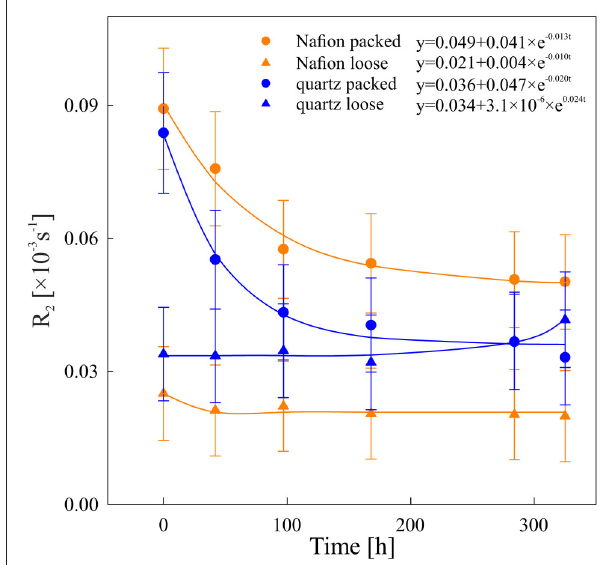
FIGURE 4 | Degradation kinetics of chia mucilage in Nafion packed (orange circles), Nafion loose (orange triangles), quartz packed (blue circles), and quartz loose (blue triangles). Data was fitted against an exponential degradation rate y = a + C 0 exp ( − kt ) , see Equation